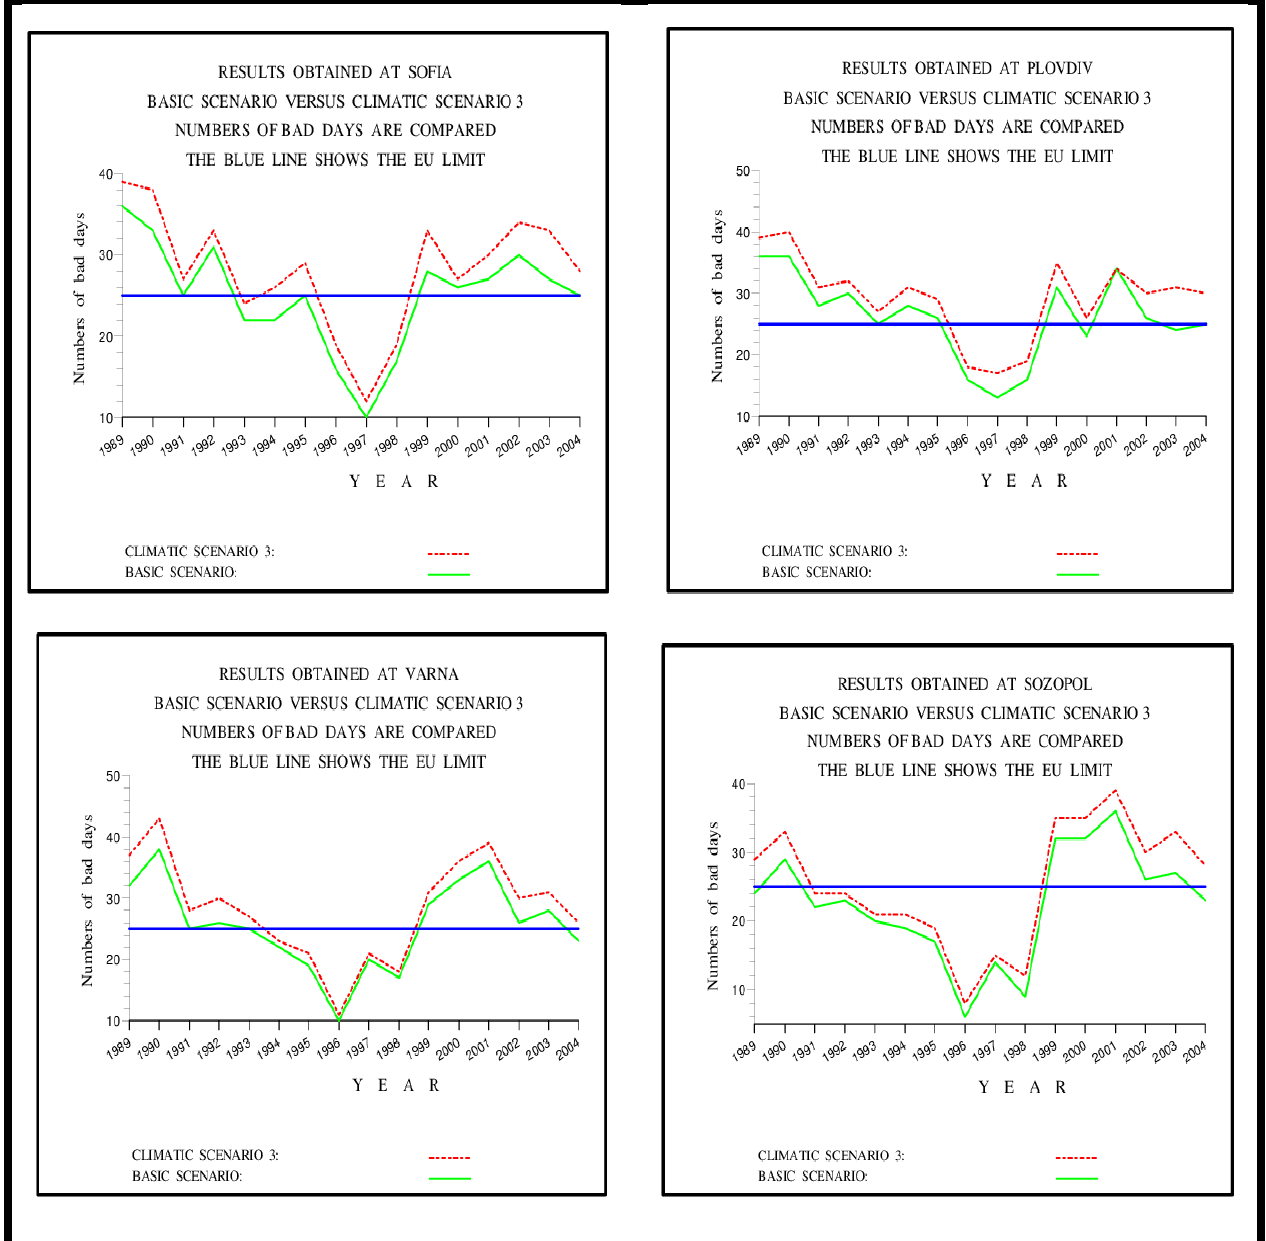
Figure 9. Results obtained in four Bulgarian towns: Sofia, Plovdiv, Varna and Sozopol. The Third Climatic Scenario is consistently resulting in an increase of the numbers of “bad-days” when it is compared with the Basic Scenario.